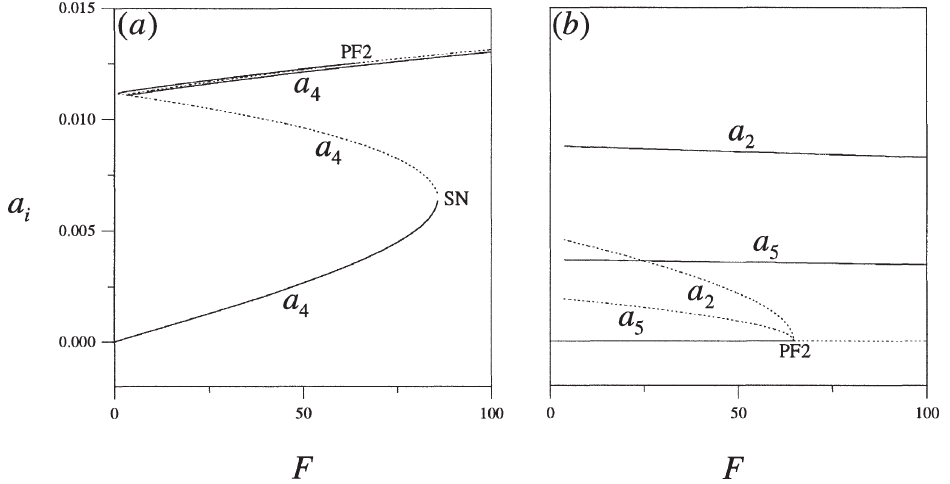
Fig. 5. Amplitude-response curves for the case (cid:10) (cid:25) ! 4 (cid:25) 1 ( ! 2 + ! 5 ) when (cid:27) 1 = 10, (cid:27) 2 = (cid:0) 15, (cid:22) 2 = 0 : 0635, (cid:22) 4 = 0 : 0573, and 2 (cid:22) 5 = 0 : 0400. Solid lines (—) denote stable fixed points and dotted lines ( (cid:1)(cid:1)(cid:1) ) denote unstable fixed points. PF2 denotes a subcritical pitchfork bifurcations and SN denotes a saddle-node bifurcation.